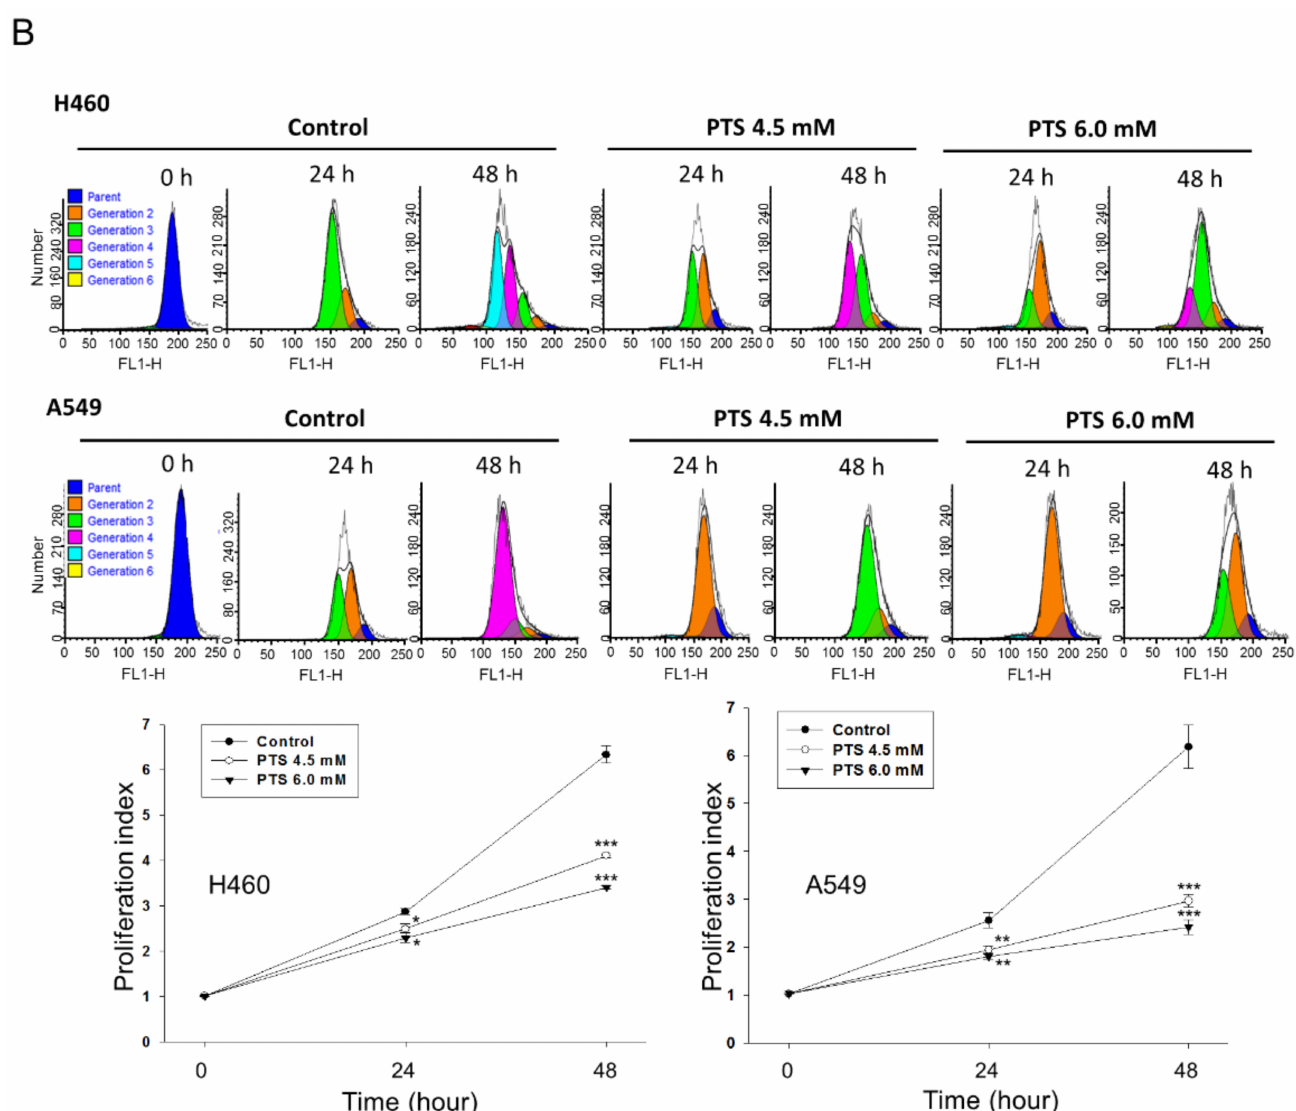
Figure 1. Effect of para -toluenesulfonamide on cell proliferation in NCI-H460 and A549 cells. ( A ) The cells were incubated in the absence or presence of para -toluenesulfonamide for 10 days. After treatment, cells were fixed and stained for colony formation assay. ( B ) The cells were incubated with or without para -toluenesulfonamide. After treatment, cells were harvested for flow cytometric analysis of CFSE staining. The cell populations of parent or different generations and proliferation index were calculated by Modfit LT Version 3.2 and WinList Version 5.0 software. Quantitative data are expressed as mean ± SEM of three independent experiments. * p < 0.05, ** p < 0.01 and *** p < 0.001 compared with the